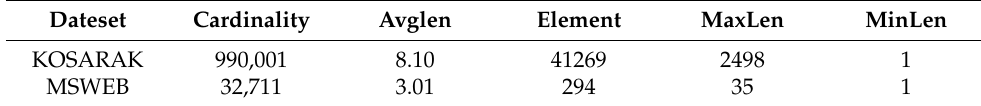
Table 3. The statistics of the two